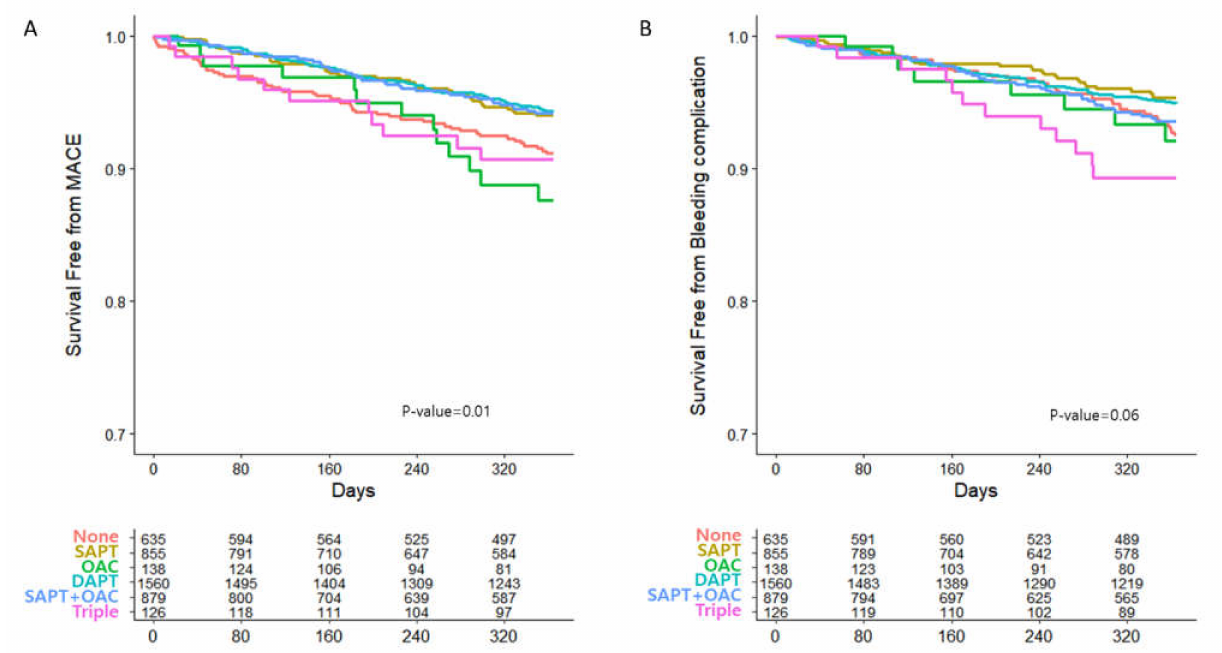
Figure 2. Kaplan–Meier Curves for primary efficacy and safety endpoints in the total study groups. ( A ) The primary efficacy outcome is MACE defined as a composite of all-cause death, myocardial infarction and stroke. ( B ) The safety outcome is bleeding events defined as an admission with an endoscopic or endovascular procedure for hemostasis or red blood cell transfusion. DAPT, dual antiplatelet therapy; MACE, major adverse cardiac events; OAC, oral anticoagulant; SAPT, single antiplatelet